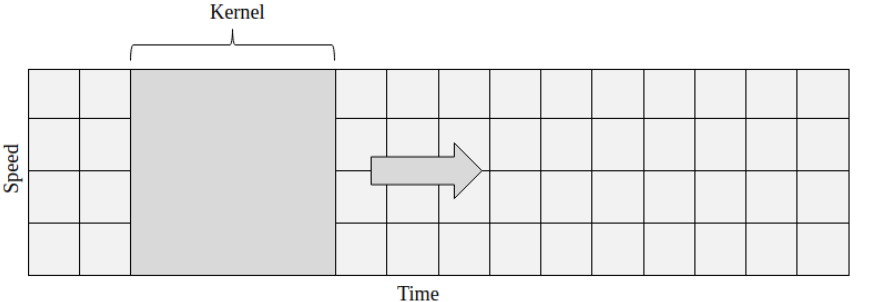
Figure 1. 1D convolution operation on a traffic state